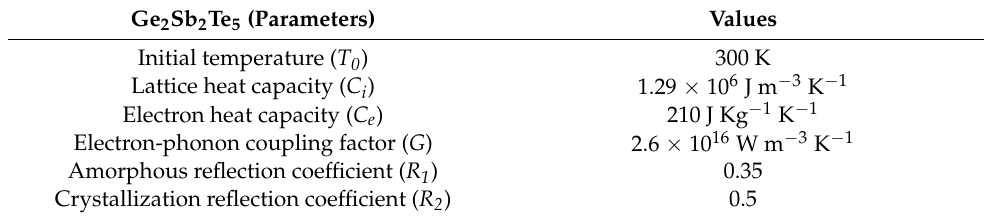
Table 1. Parameters for Ge 2 Sb 2 Te 5 used in heat calculation